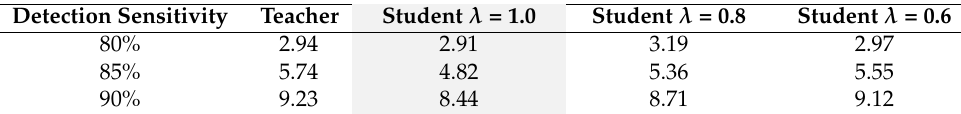
Figure 8. The impact of λ on the AFP metric. The student model performances for ( a ) λ = 1.0 (default setup), ( b ) λ = 0.8, ( c ) λ = 0.6, and ( d ) comparisons between the teacher and student models with these setups are presented. Table 3. AFP vs sensitivity for different 𝝀 values.